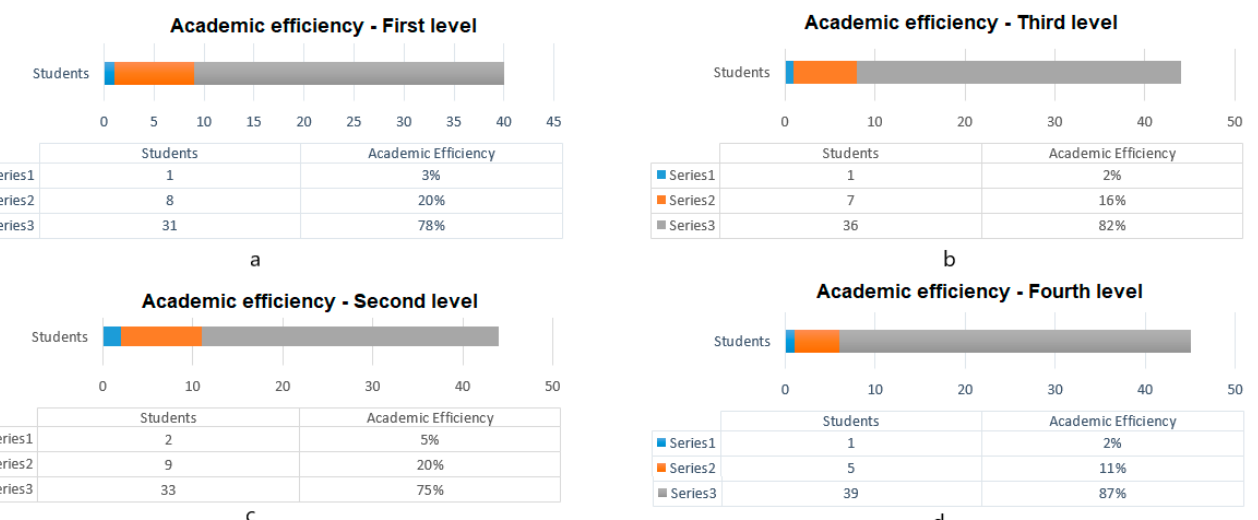
Figure 10. Evaluation of academic effectiveness vs. the learning of fourth-level students in the current education model (classes through synchronous meetings).